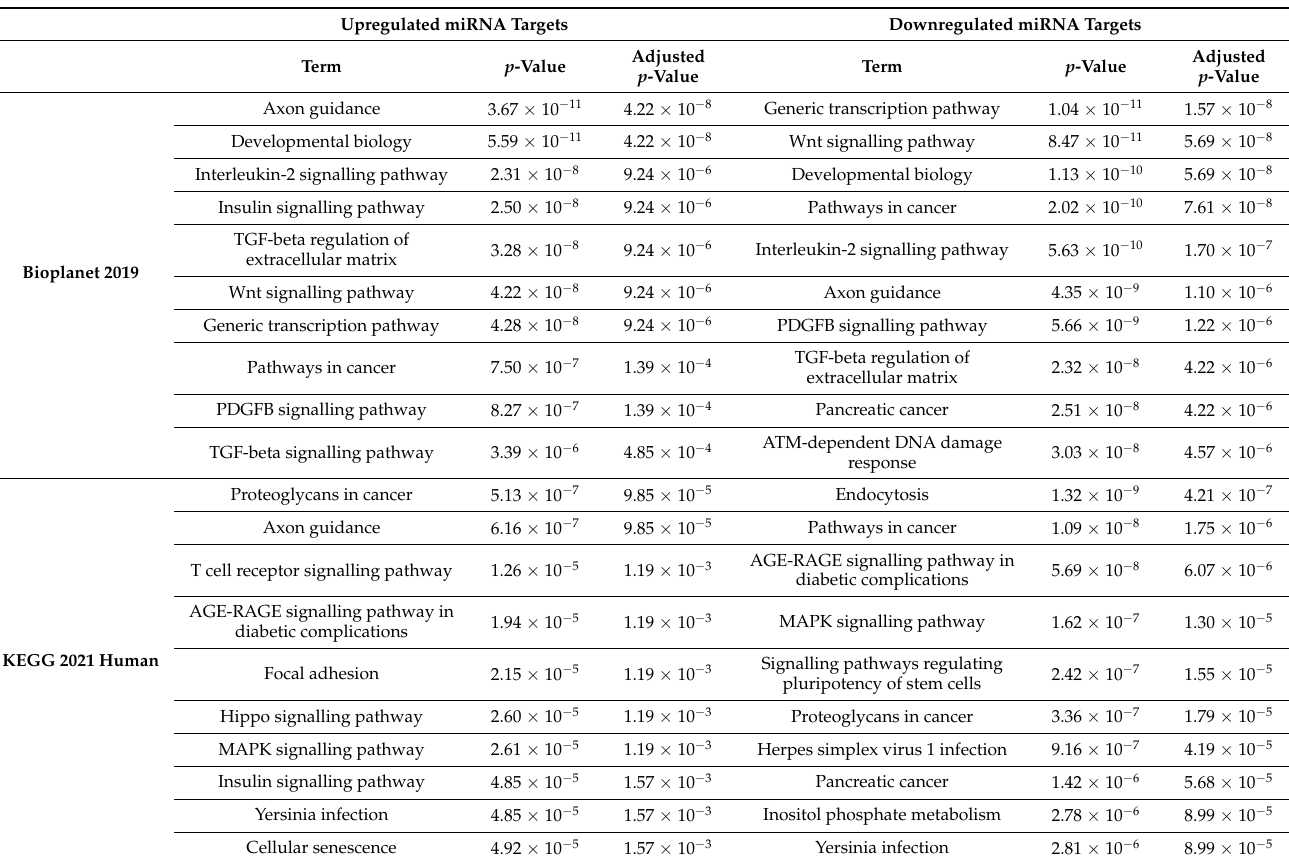
Table 2. Pathways altered by dysregulated NMV miRNA targets in AD